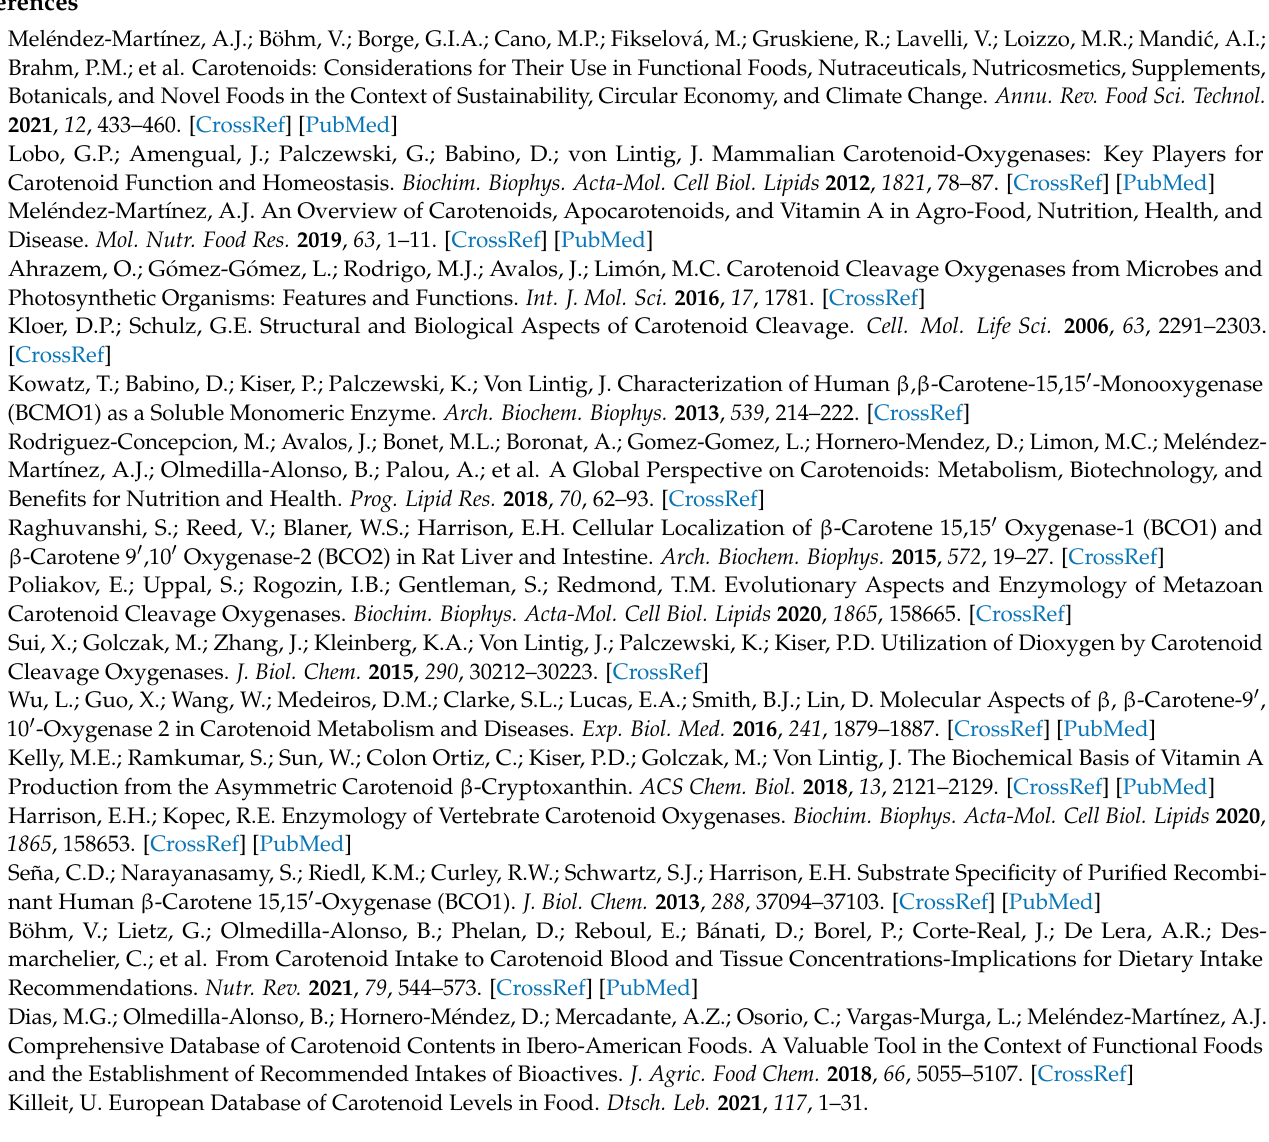
BCO1 with β -carotene (Uab); Figure S17: Statistical analysis of the interaction frequency of